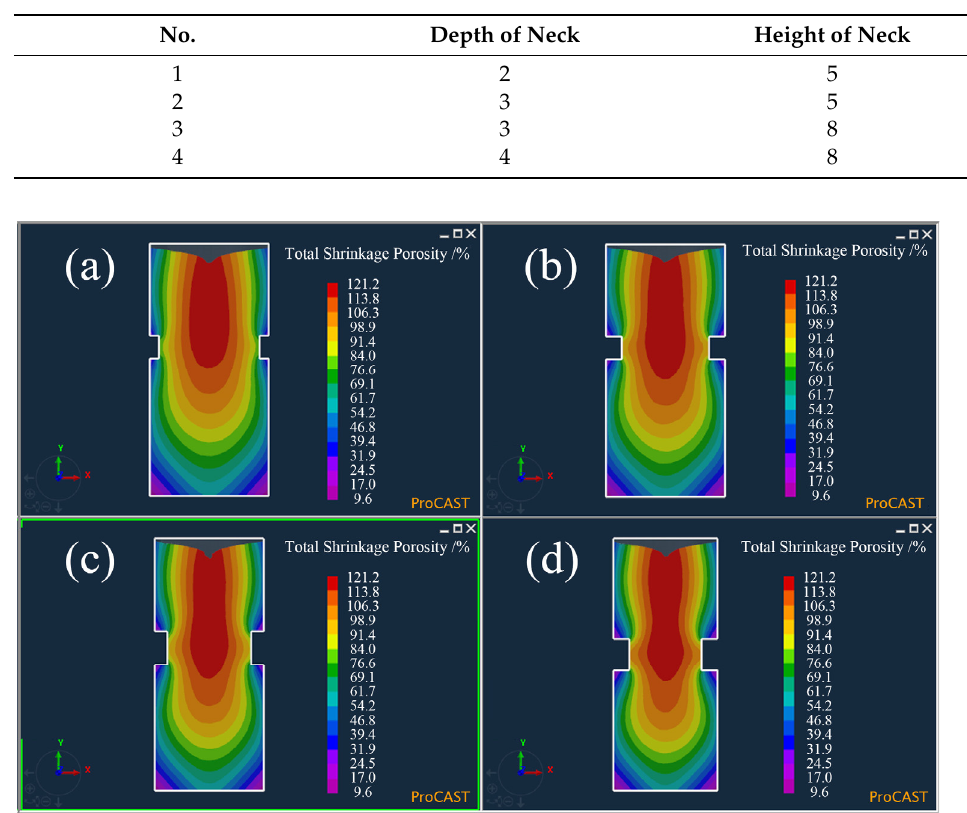
Table 2. Four different neck sizes for the Ø26 × 55 mm sample (mm).